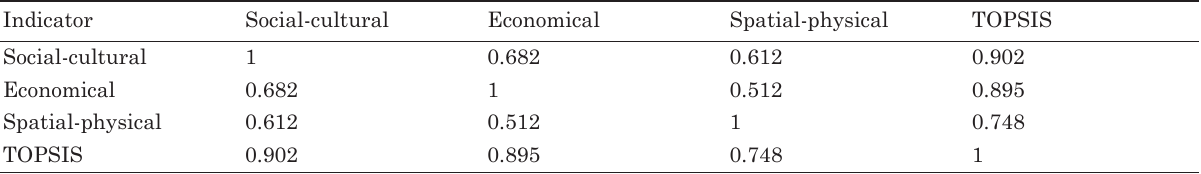
Table 5. Correlation of each development indicator with the total indicator (TOPSIS) TOPSISSpatial-physicalEconomicalSocial-culturalIndicator 0.9020.6120.6821Social-cultural 0.8950.51210.682Economical 0.74810.5120.612Spatial-physical 10.7480.8950.902TOPSIS